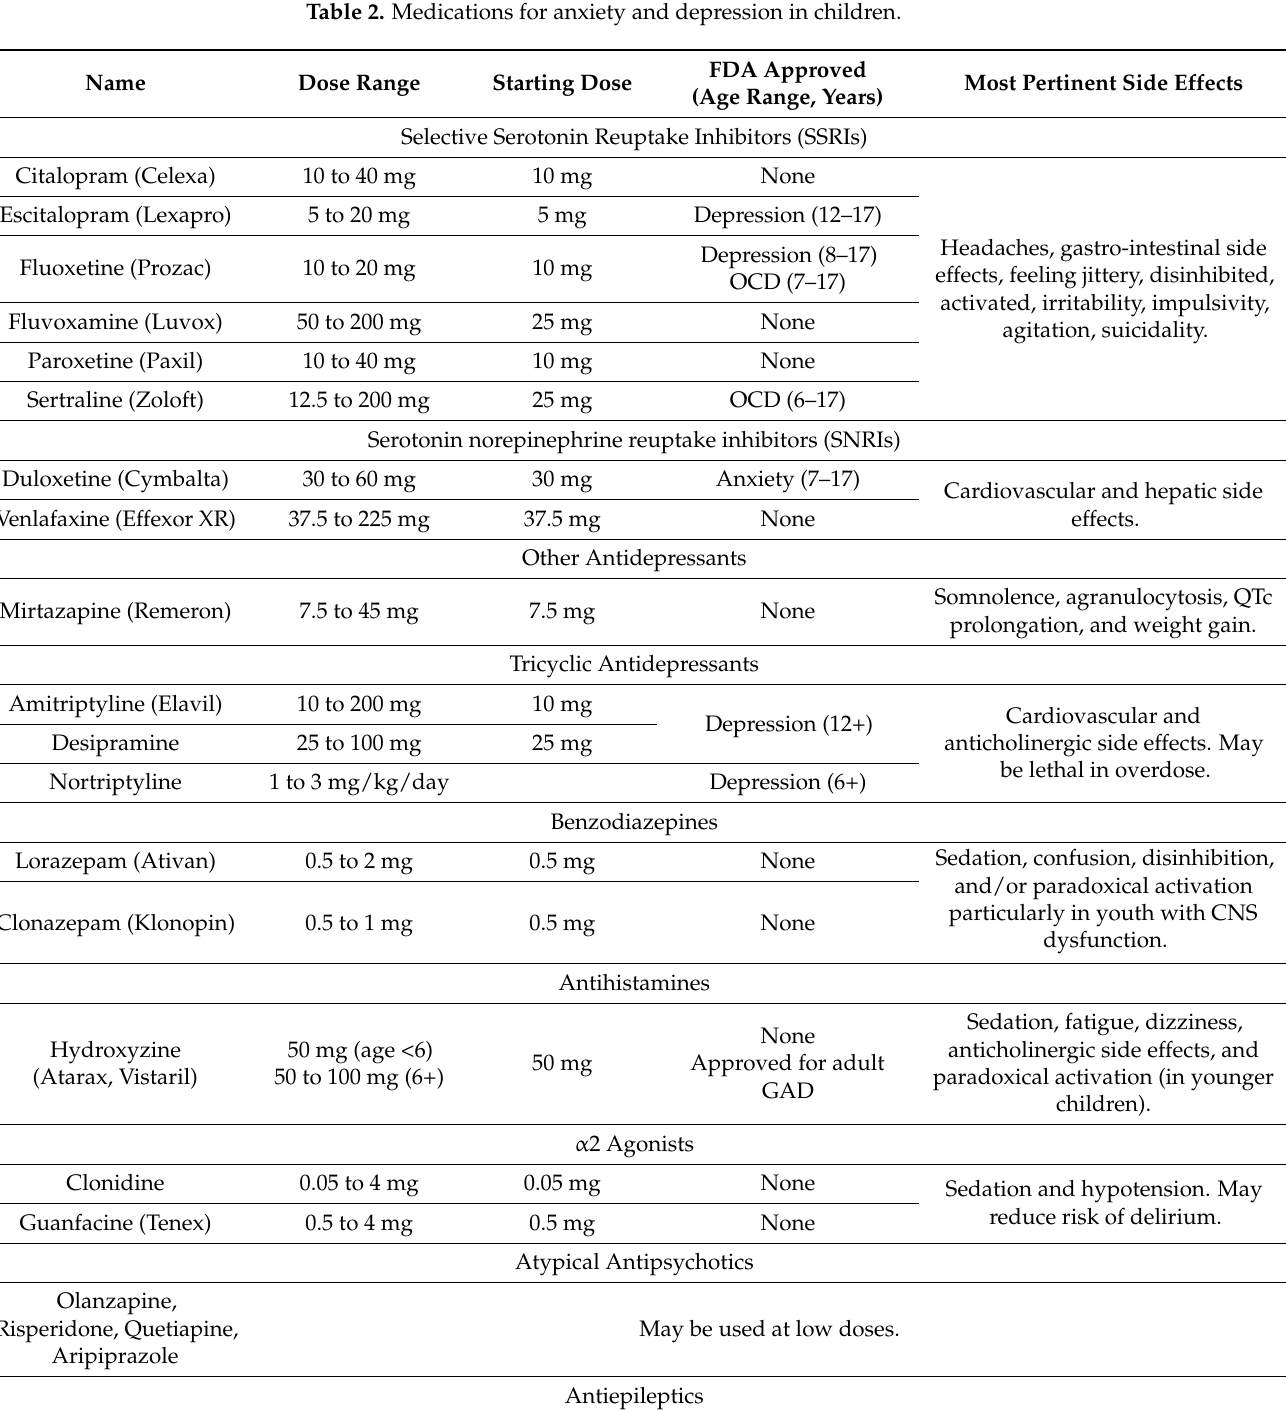
Table 2. Medications for anxiety and depression in